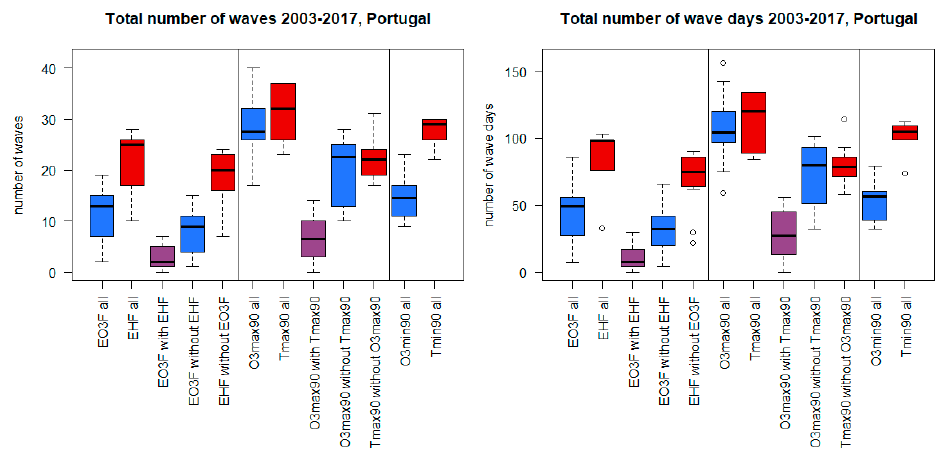
Figure 3. Total number of waves (left) and total number of wave days (right) across the 14 stations of Portugal in the period 2003–2017. Wave type abbreviations and colour coding as in Figure 2.